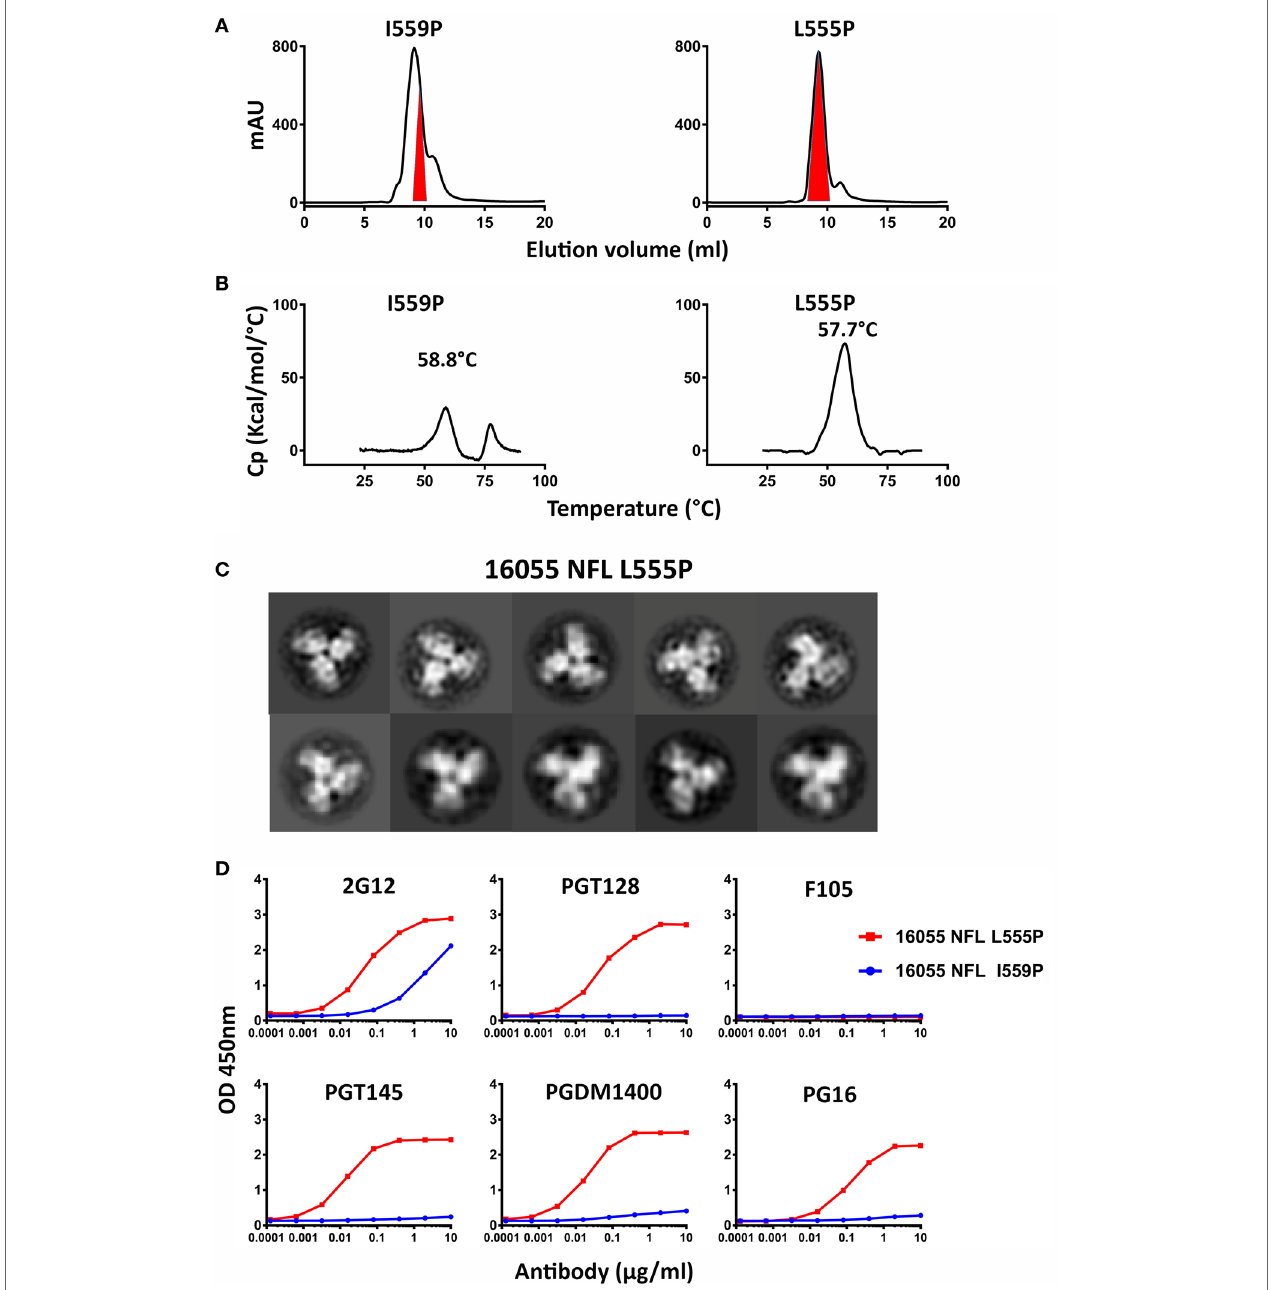
FigUre 2 | Biochemical, biophysical, and antigenic characterization of 16055 NFL trimers possessing the L555P substitution. (a) Comparison of the size exclusion chromatography profiles of the 16055 NFL trimers possessing the I559P and L555P substitutions following lectin-affinity purification. The shaded red area indicates the native-like trimer fractions. The yields are summarized in Table 1 . (B) Differential scanning calorimetry measurements of 16055 NFL trimers possessing either I559P or L555P. The data for 16055 NFL I559P are adapted as previously reported (19). The T m values are shown on top of the peaks and are summarized in Table 1 . (c) 2D class averages from negative stain electron microscopy (NS-EM) of 16055 NFL L555P trimers purified by negative selection using GE136. (D) ELISA binding of selected mAbs to the NFL trimers and the half-maximal binding concentrations (EC 50 , in µg/ml) are summarized in Table 2 .